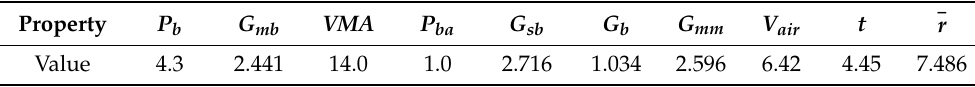
Table 6. Properties of asphalt